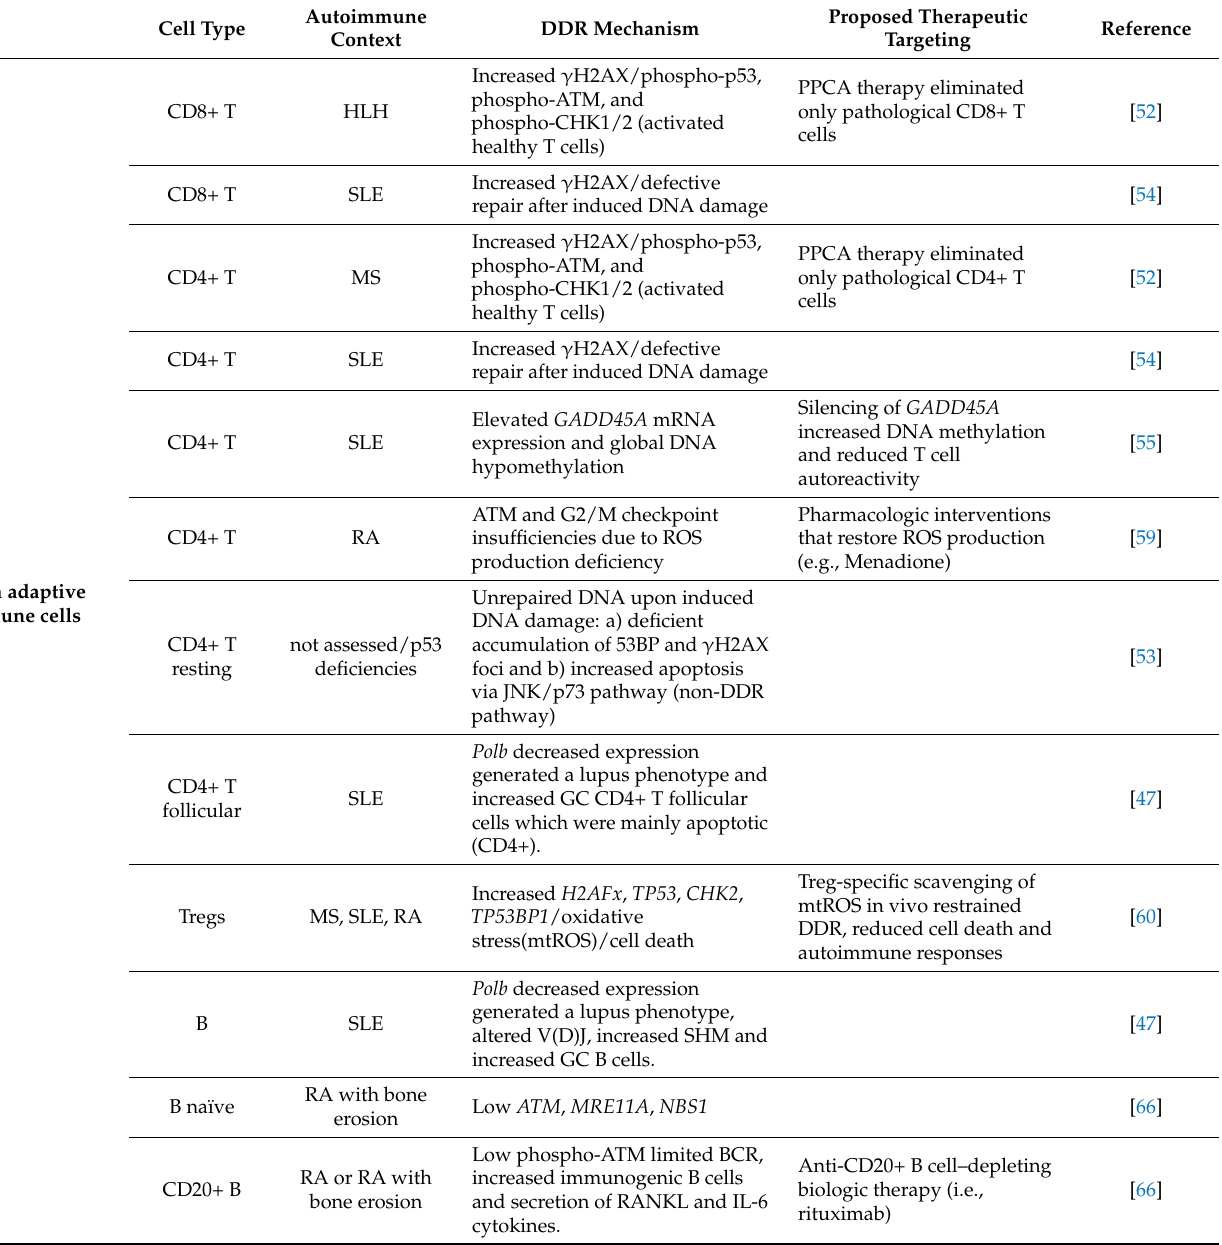
Table 1. Key findings in studies addressing DDR of adaptive and adaptive-related immune